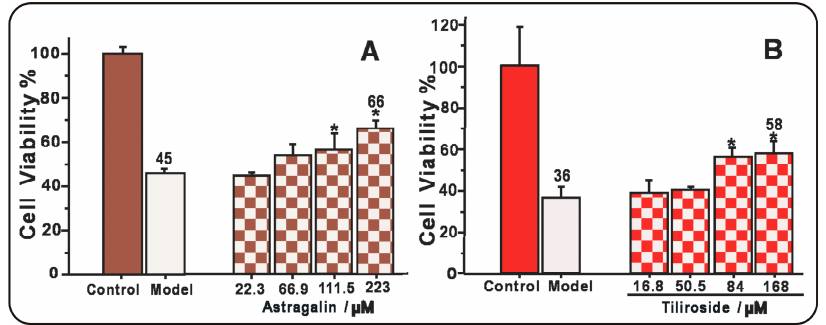
Figure 6. Protective effects of astragalin ( A ) and tiliroside ( B ) against the •OH-induced damage of MSCs using an MTT assay. The •OH radicals were generated by Fenton reagent (FeCl 2 plus H 2 O 2 ). These data represent the mean ± SD ( n = 5). * p < 0.05 vs model.